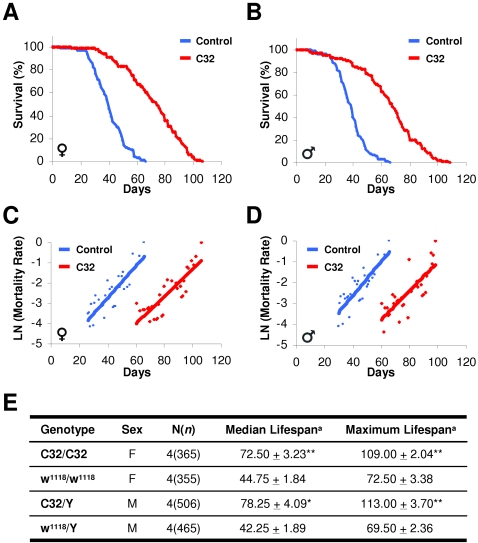

C32 Flies Are Long-lived.(A, B) Adult female (A) or male (B) C32 and control w1118 flies were identically reared and survival was assessed daily. (n>80 per group, p<0.0001 by log-rank test) (C, D) Log mortality plots for adult female (C) or male (D) C32 and control w1118 flies identically reared. (n>80 per group, p<0.0001 by log-rank test) (E) Table summarizing four independent lifespan analyses of C32 and control flies. aValues are mean of the median and maximum lifespan of C32 and w1118 control female (F) and male (M) flies±standard error of the mean. N, number of replicates. n, total number of flies examined. * p <0.001, ** p <0.0003 by student's t-test.